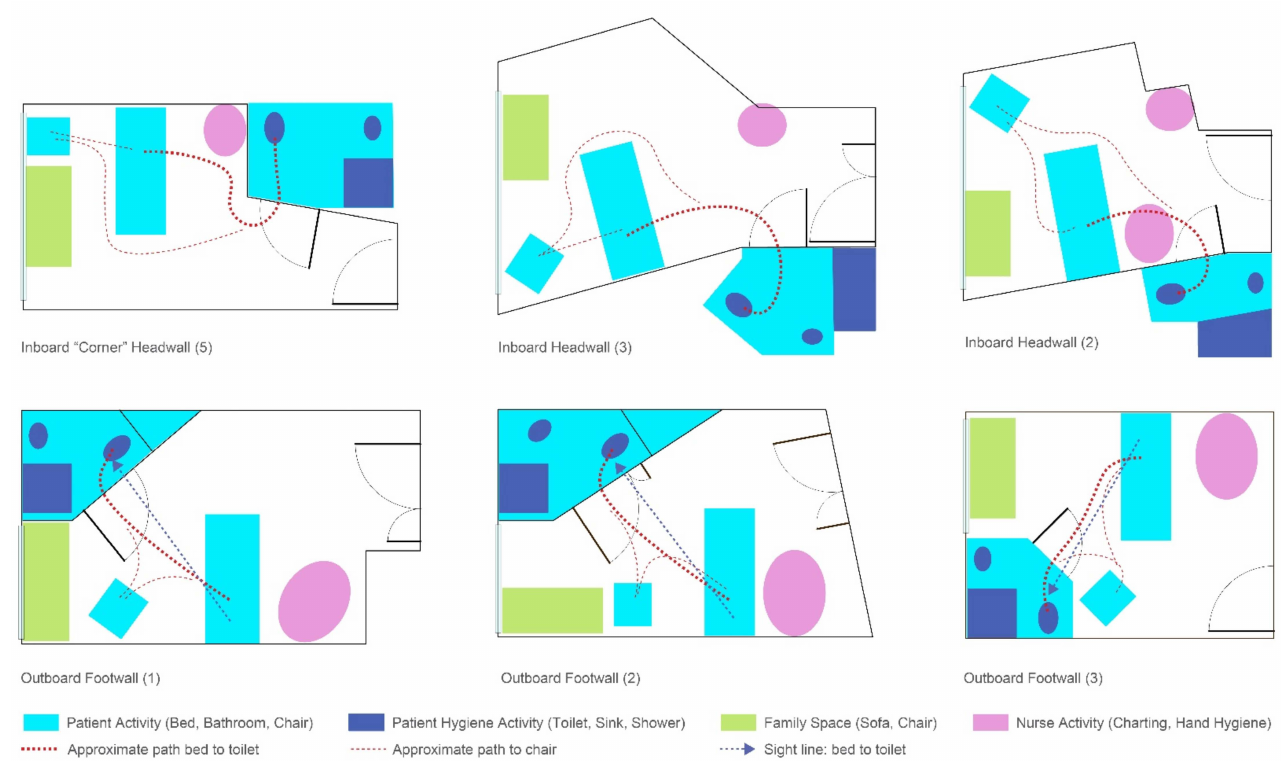
Figure 3. Room configurations used in the